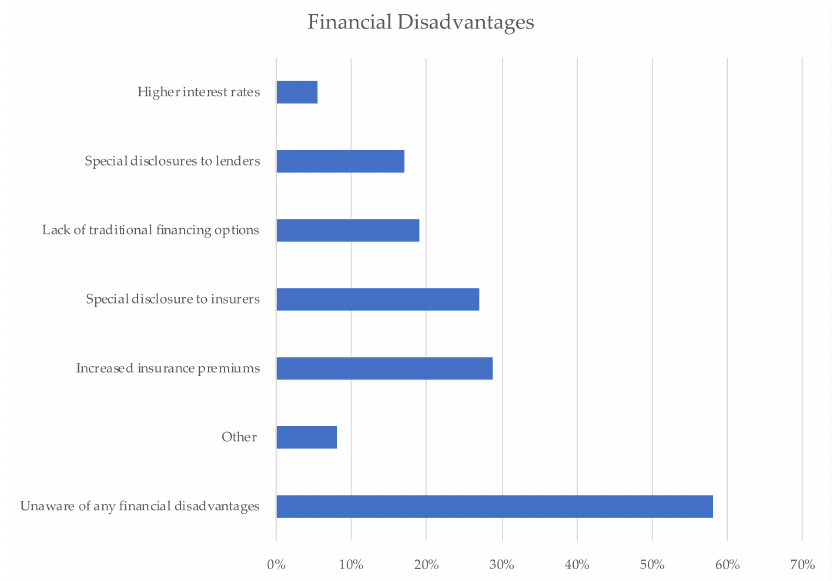
Figure 6. Responses to the question ‘Which of the following financial disadvantages are related to the use of timber in multi-storey